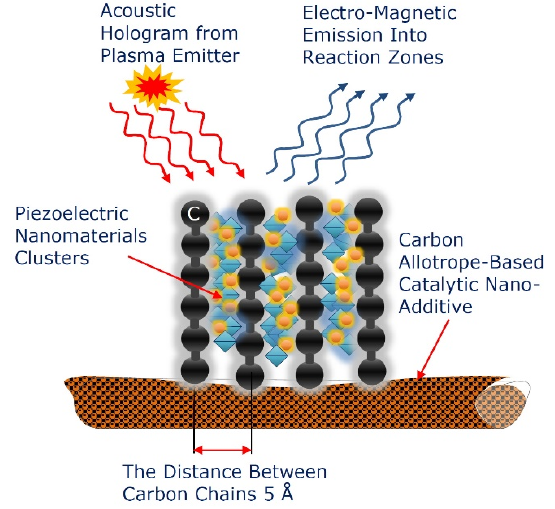
Figure 13. Schematic representation of the acoustic hologram transformation into the electromag- netic hologram through the 2D-ordered linear-chain carbon-based functionalizing nanocarrier, as- sembled by the piezoelectric nanomaterial clusters. by the piezoelectric nanomaterial